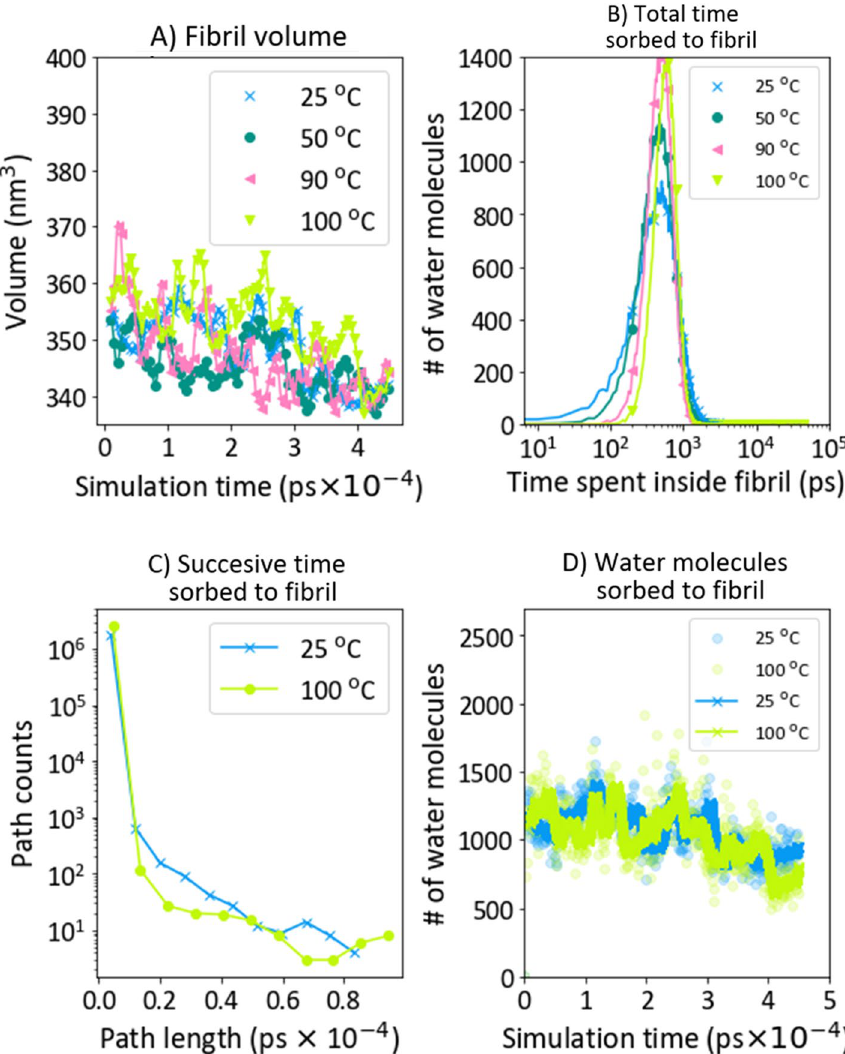
Figure 7. Swelling at different temperatures. Curves in ( A ) and ( D ) represent a moving average with n = 100. In ( D ), points are actual